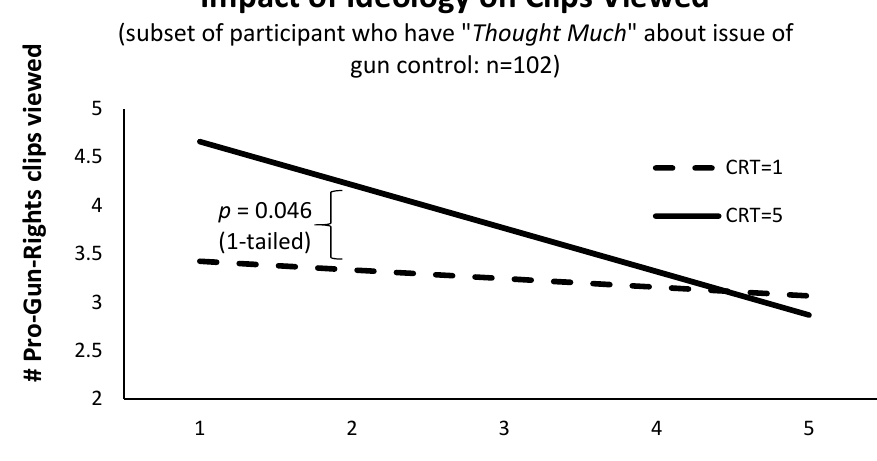
Figure 2. WR and cognitive reflection promote the confirmation bias. ( a ) Impact of Sleep Treatment on # PRO-GUN-RIGHTS CLIPS viewed; ( b ) Impact of Cognitive Reflection on # PRO-GUN-RIGHTS CLIPS viewed. Notes : Effect shown for models (3) and (7) in Table 6, which included control variables and used the subset of participants who complied with their prescribed sleep assignment from the larger sleep study. Negatively sloped forecast lines are consistent with the confirmation bias, but the steeper profile of the WR (upper panel) and CRT = 5 (lower panel) forecast lines indicate a more severe confirmation bias.